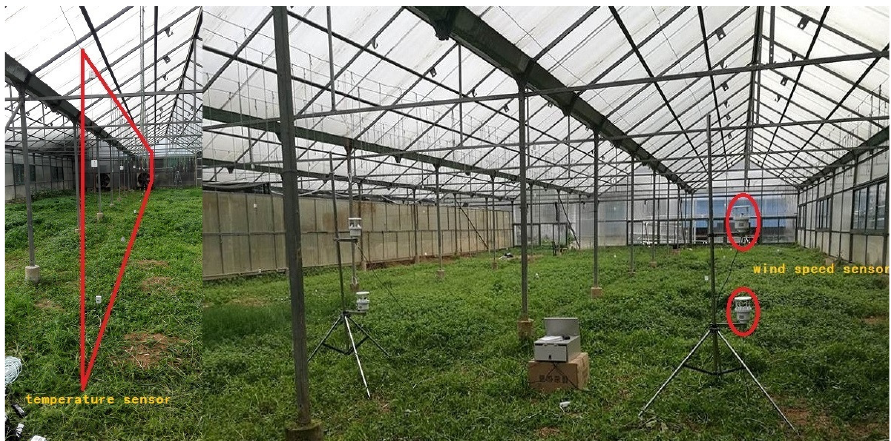
Figure 7. The experimental scene in the Venlo type commercial